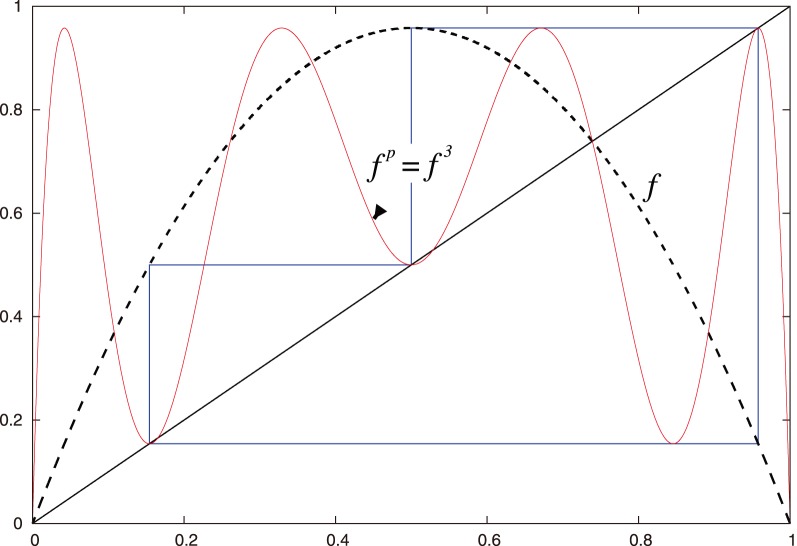
The 3-periodic orbit  from Fig. 2.